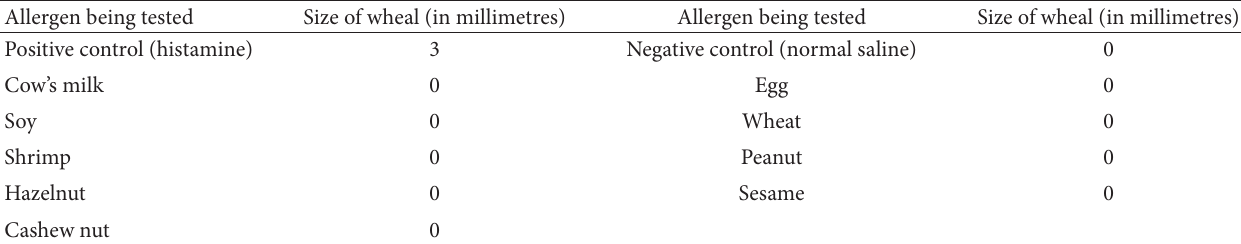
Table 1: Skin prick testing at six months of